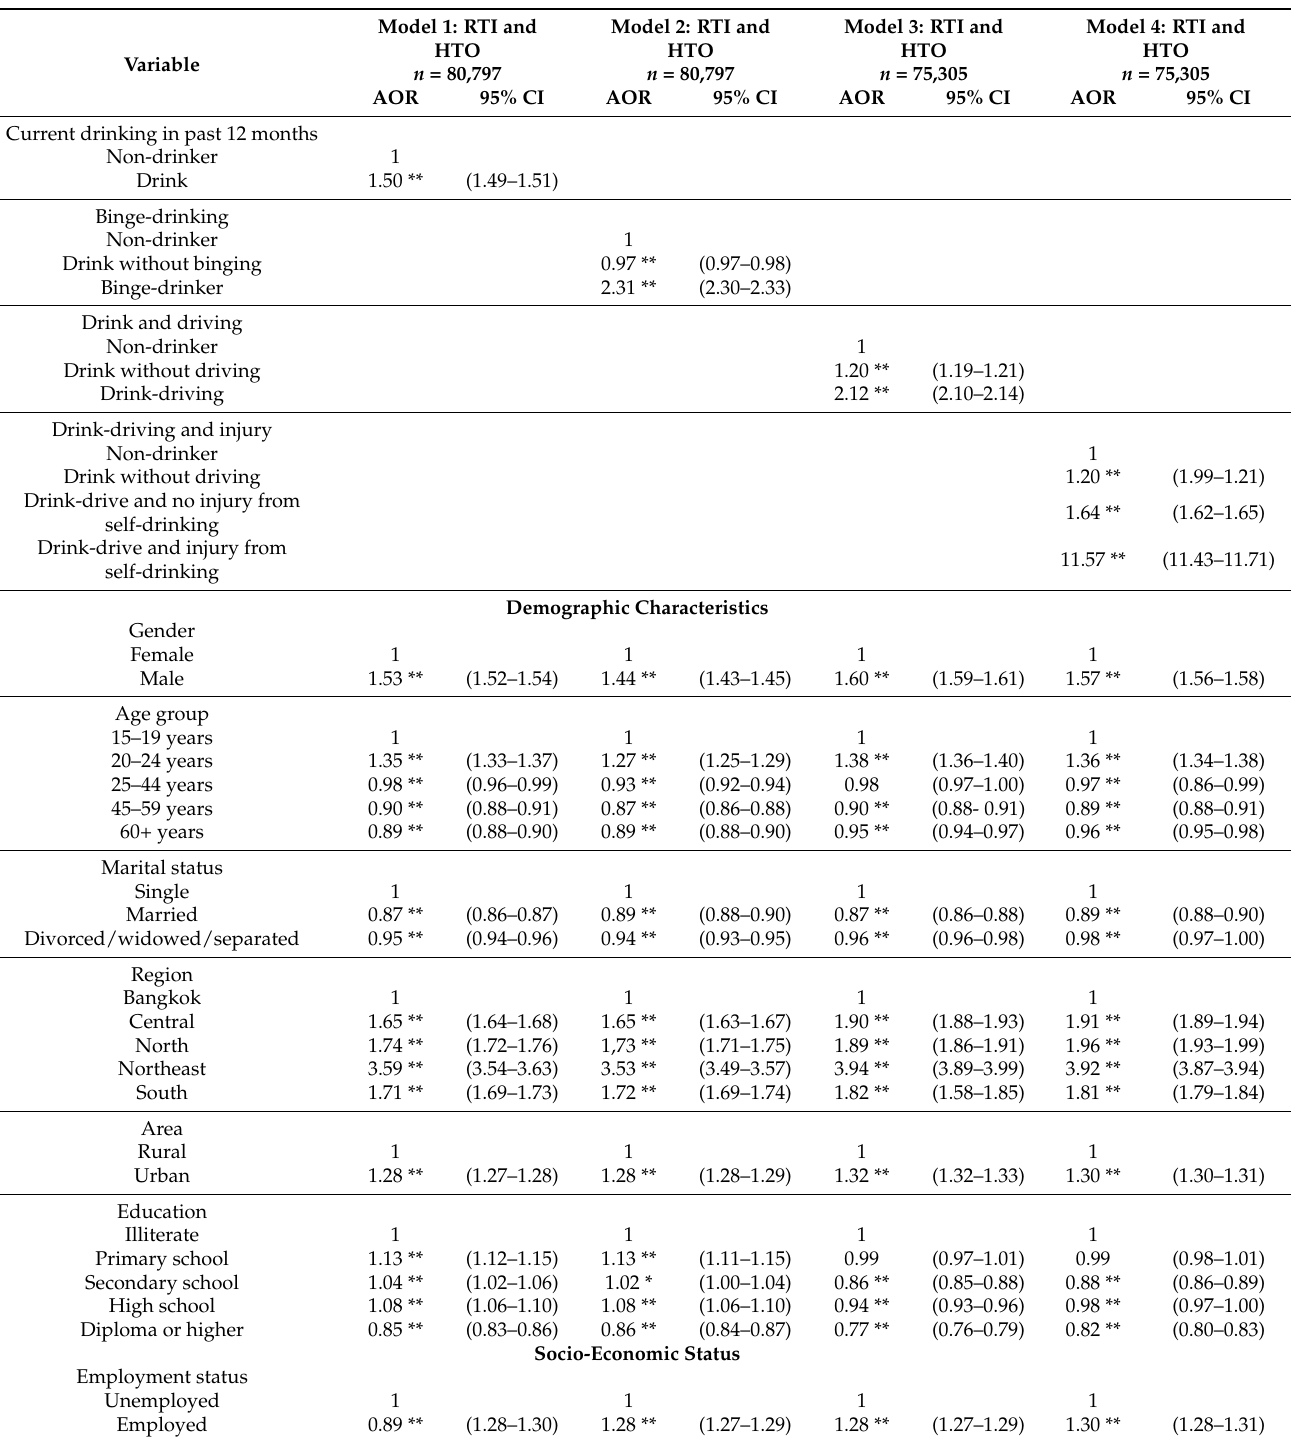
Table 2. Factors associated with the respondents’ current drinking, binge drinking, drink-driving behavior, harm from road traffic injuries due to self-drink-driving behavior, and having experienced harm from road traffic injuries due to others’ drink-driving behavior ( n =